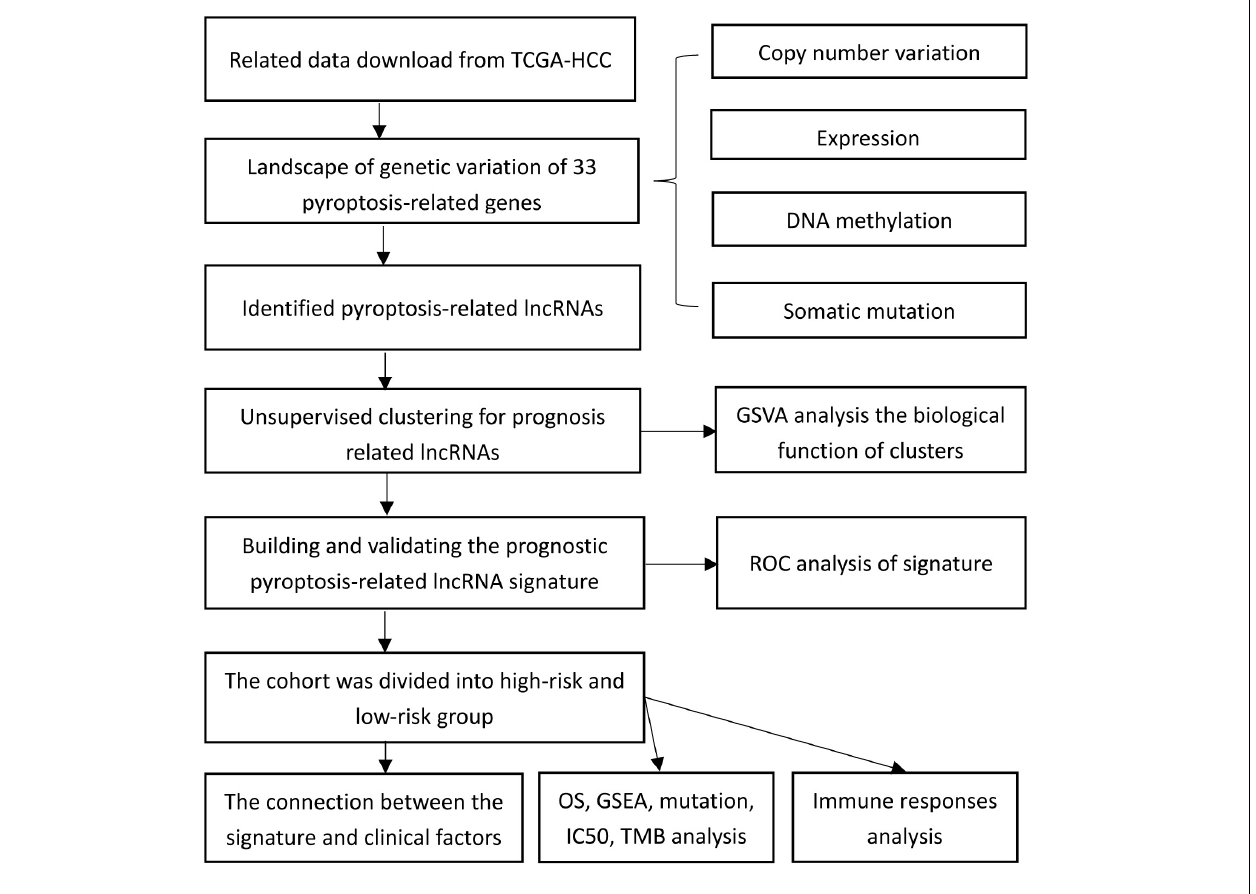
FIGURE 1 | The flow chart showing the scheme of the study.